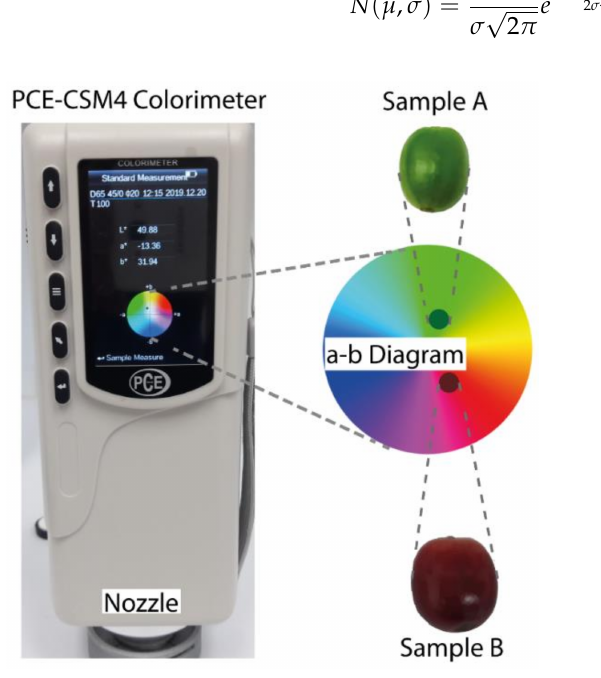
Figure 1. Color measurement on coffee fruits with a